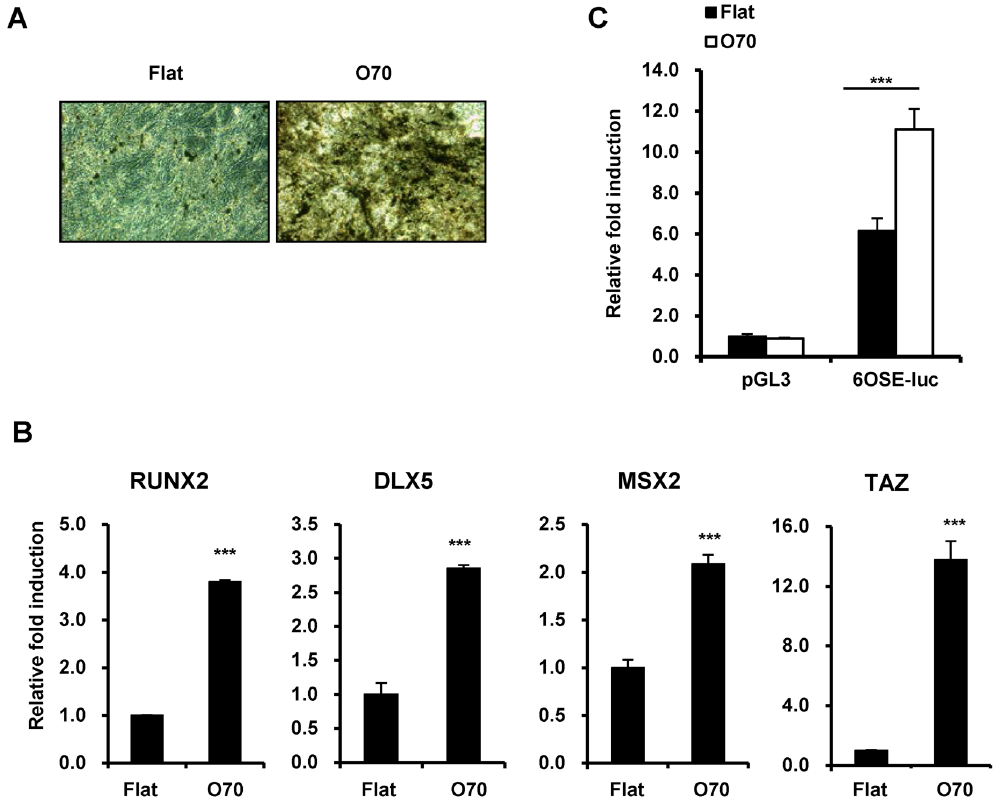
Figure 3. The O70 nanopattern plate promotes osteogenesis of MSC. ( A ) MSC on flat or nanopattern plates were differentiated for 14 days and calcium deposition was analyzed by Von Kossa staining. ( B ) Cells in ( A ) were harvested and transcripts of RUNX2 , DLX5 , MSX2 , and TAZ were analyzed by qRT-PCR. n = 3, *** p < 0.005, t-test. ( C ) MSC were transfected with pGL3 basic or 6OSE2-luc plasmid along with RUNX2 expression plasmid and re-seeded on flat or nanopattern plates after 16 hr. At 24 hr after re-seeding, cells were harvested, and luciferase activity was analyzed. n = 3, *** p < 0.005,